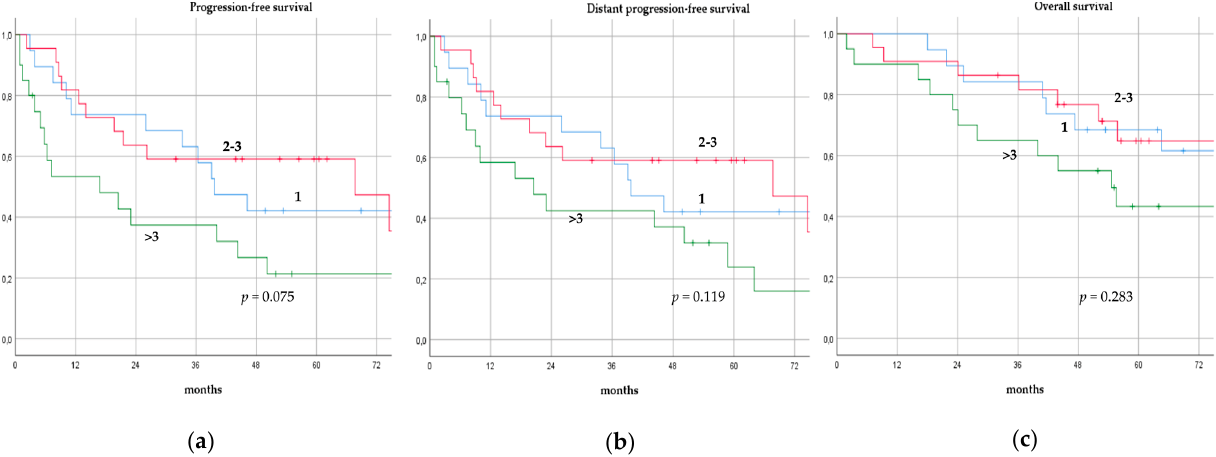
Figure 3. Progression-free survival ( a ), distant progression-free survival ( b ), and overall survival ( c ) curves of de novo metastatic breast cancer patients according to number of metastases.